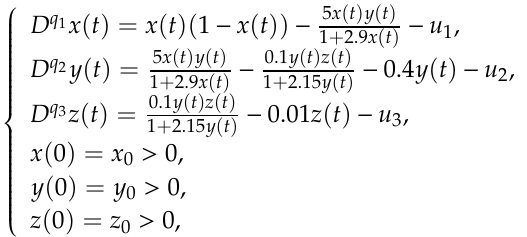
Figure 8. Bifurcation diagrams with the varying parameter d ( d ) α =